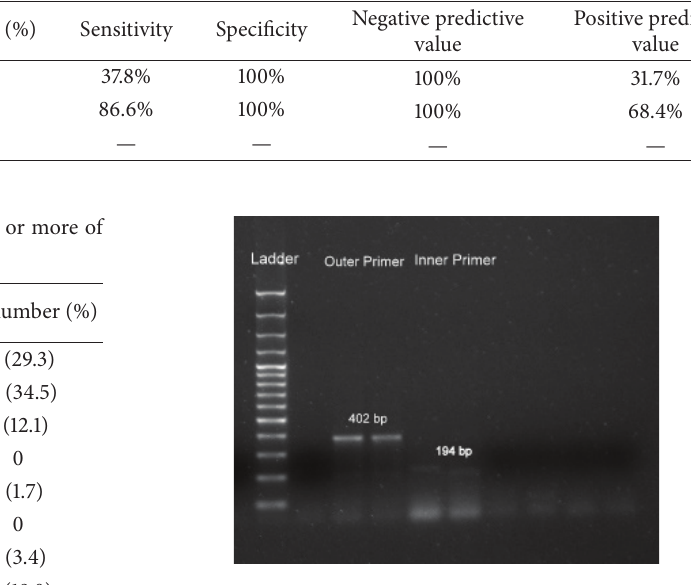
Figure 1: PCR product obtained with the first set of outer primers (402 bp) and the amplicon (194 bp) obtained after amplification with the second set of inner primers.